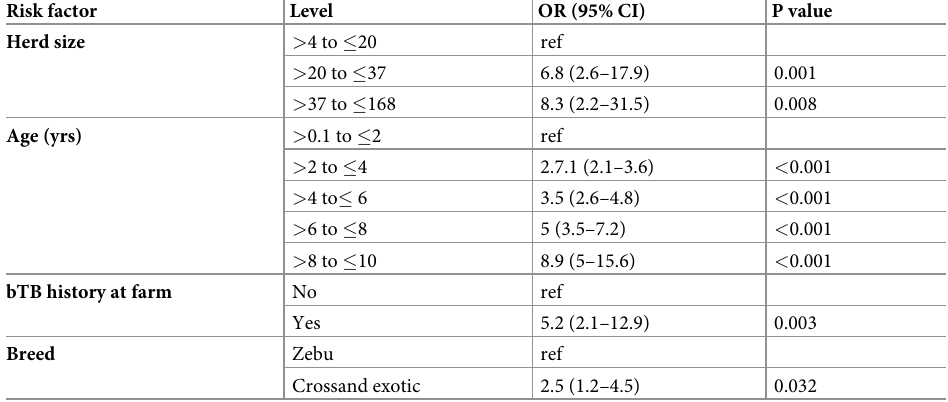
Table 5. GLMM multivariable analysis of potential risk factors for bTB positive cattle using herd and area as ran- dom